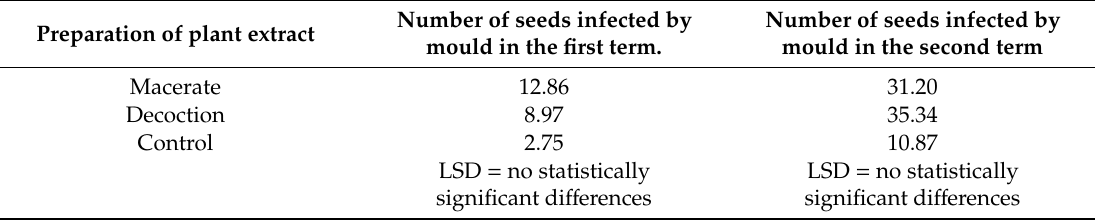
Table 5. Influence of the method of obtaining plant extracts on limiting the development of bacteria - average number of contaminated seeds (%). Number of seeds infected by Number of seeds infected Preparation of plant extract mould in the first term.